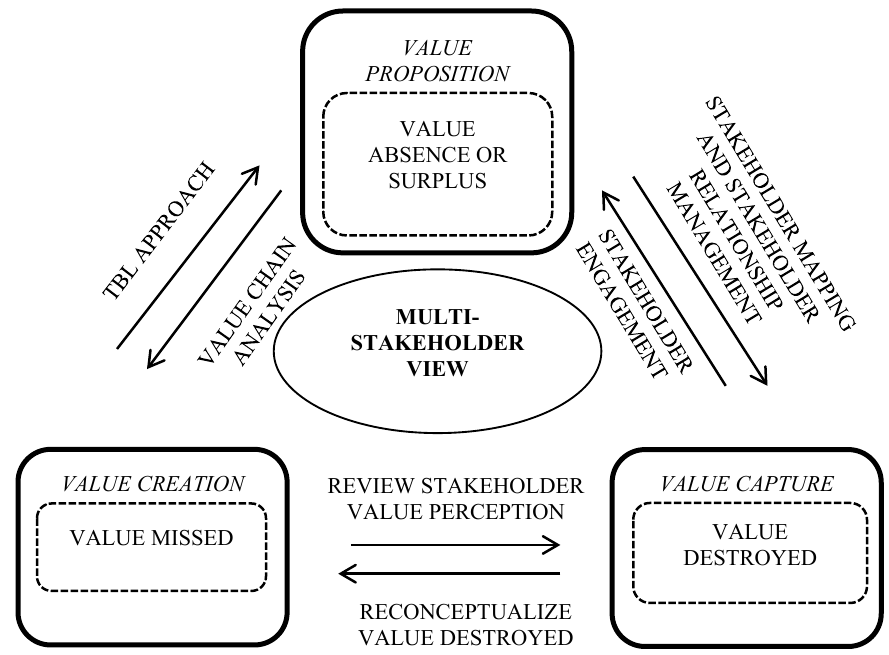
Figure 1: Generating Value from Value